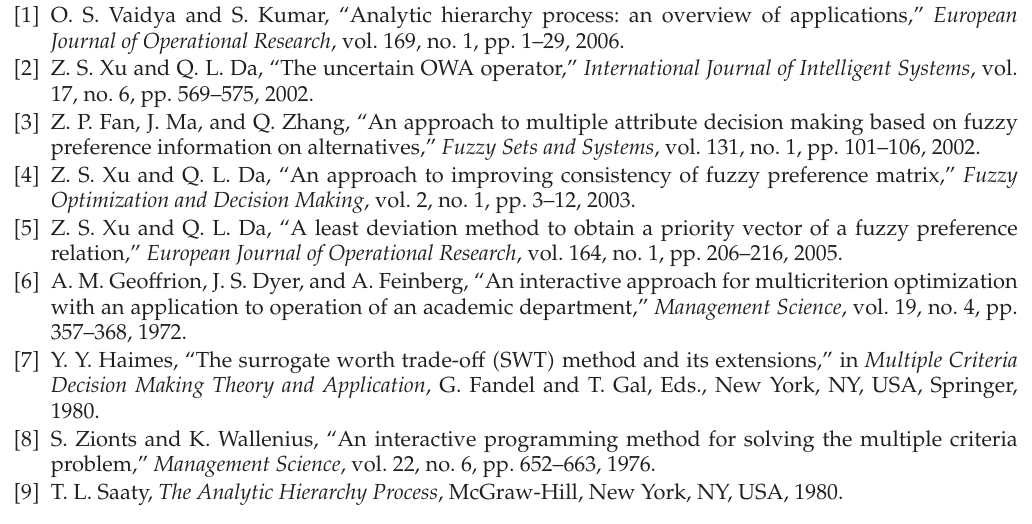
Table 8: The obtained weights of proposed method and Taha and Rostam method for Criteria Proposed method Taha and Rostam method Rank of